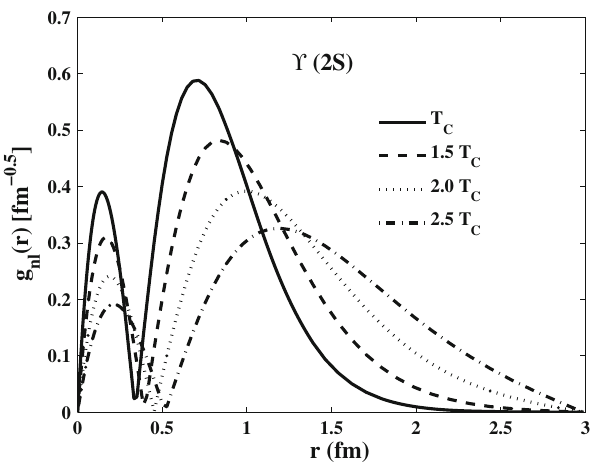
Fig. 9 Variation of radial wavefunction of ϒ( 2 S ) with respect to r at T = T C , 1 . 5 T C , 2 . 0 T C and 2 . 5 T C